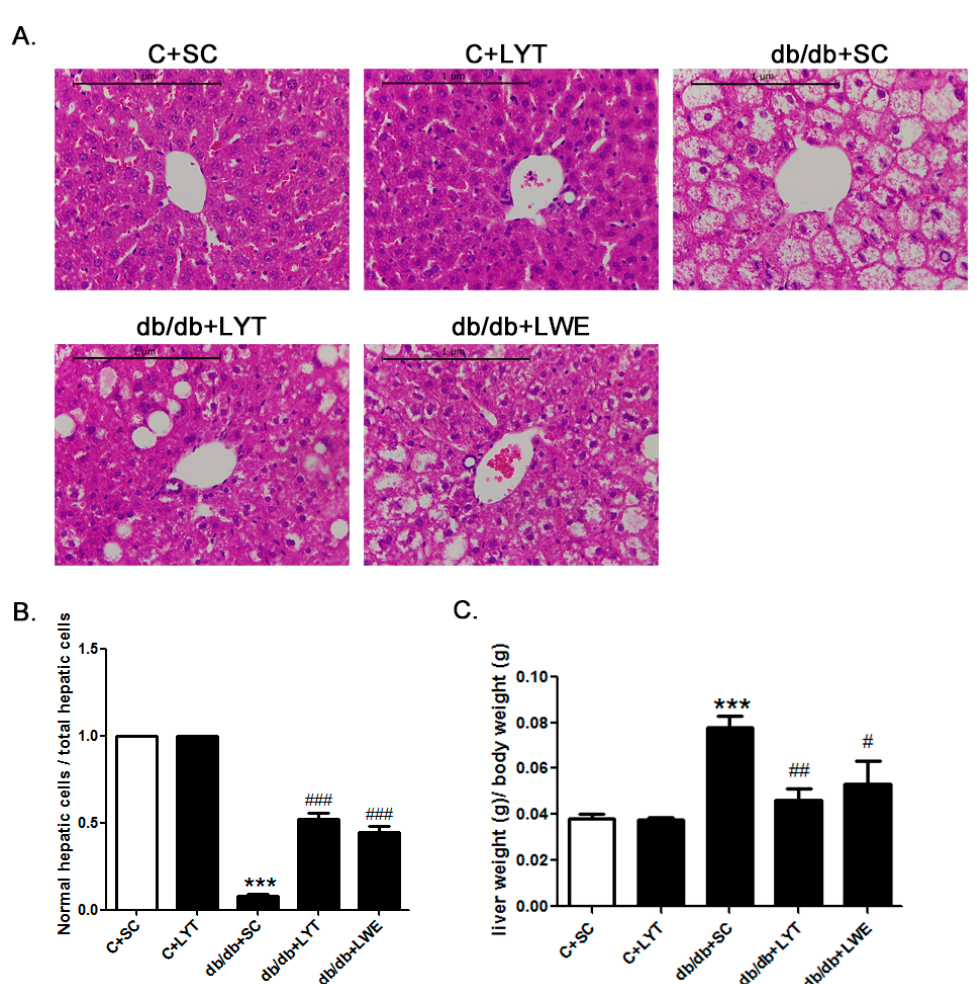
Figure 4. LYT and LWE diets attenuate hepatic steatosis and reduce liver-to-body weight ratio in db/db mice. Liver hematoxylin–eosin HE staining ( A ); normal hepatic cells to total liver cell ratio (5 field of view were randomly selected from each tissue sections for statistics ( B ); and liver-to-body weight ratio ( C ). Scale bars are equal to 1 μ m. Values are means ± SE ( n = 4–6). *** p < 0.001 when compared with the C + SC group; # p < 0.05; ## p < 0.01; ### p < 0.001 when compared with the db/db + SC group.